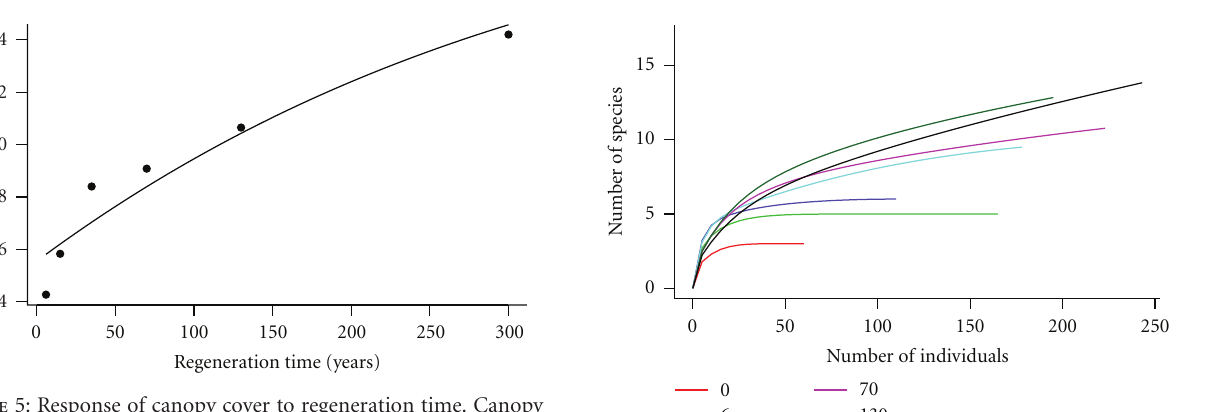
Figure 5: Response of canopy cover to regeneration time. Canopy cover increased linearly with regeneration time. Linear regression with binomial errors: y = 100 ∗ e (1 . 778+0 . 003 ∗ x ) / 1+ e (1 . 778+0 . 003 ∗ x ) ; F 1,4 = 54.24; P = 0 . 018.